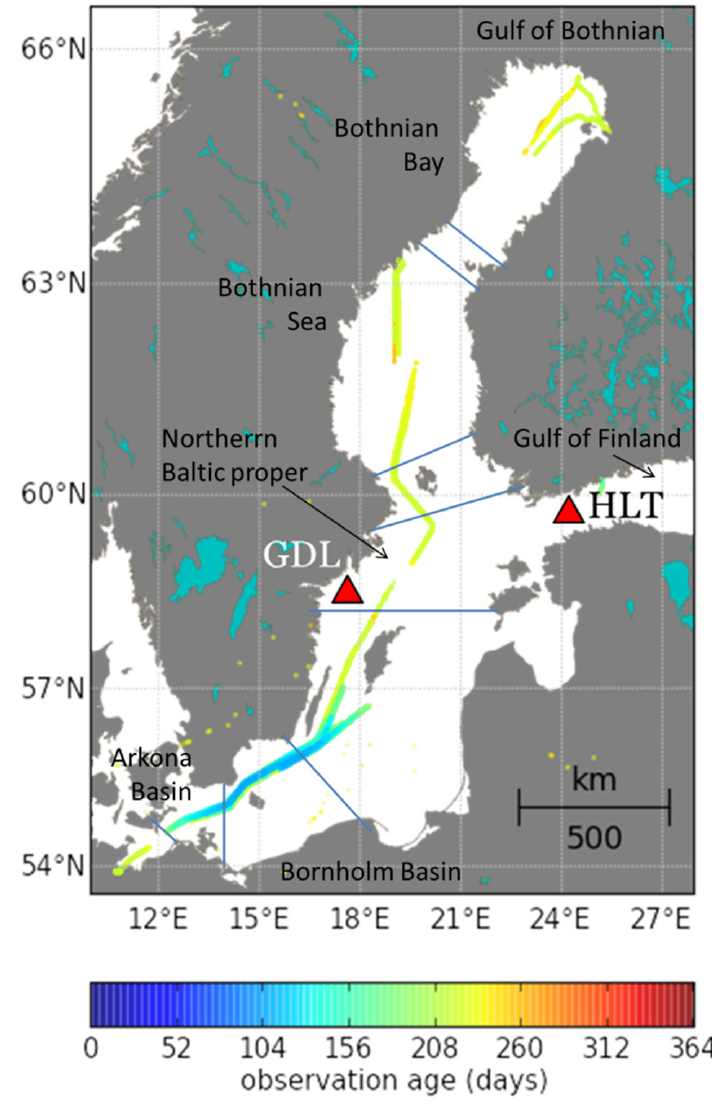
Figure 1. Locations of in situ data from the research vessel (blue–green–yellow transects) and two AERONET-OC sites (red triangles): Gustaf Dalen Lighthouse Tower (GDL) and Helsinki Lighthouse Tower (HLT). The colour scale indicates the number of days from the start of the period for which data are shown (0 = 17 January 2016).